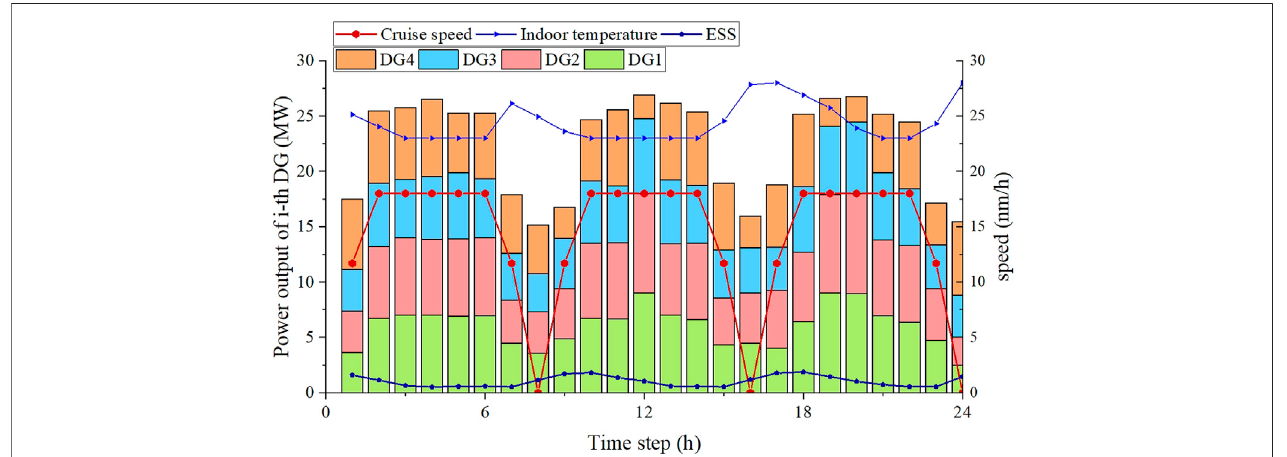
FIGURE 5 | Hourly power output of coordinated optimal power management and voyage scheduling.